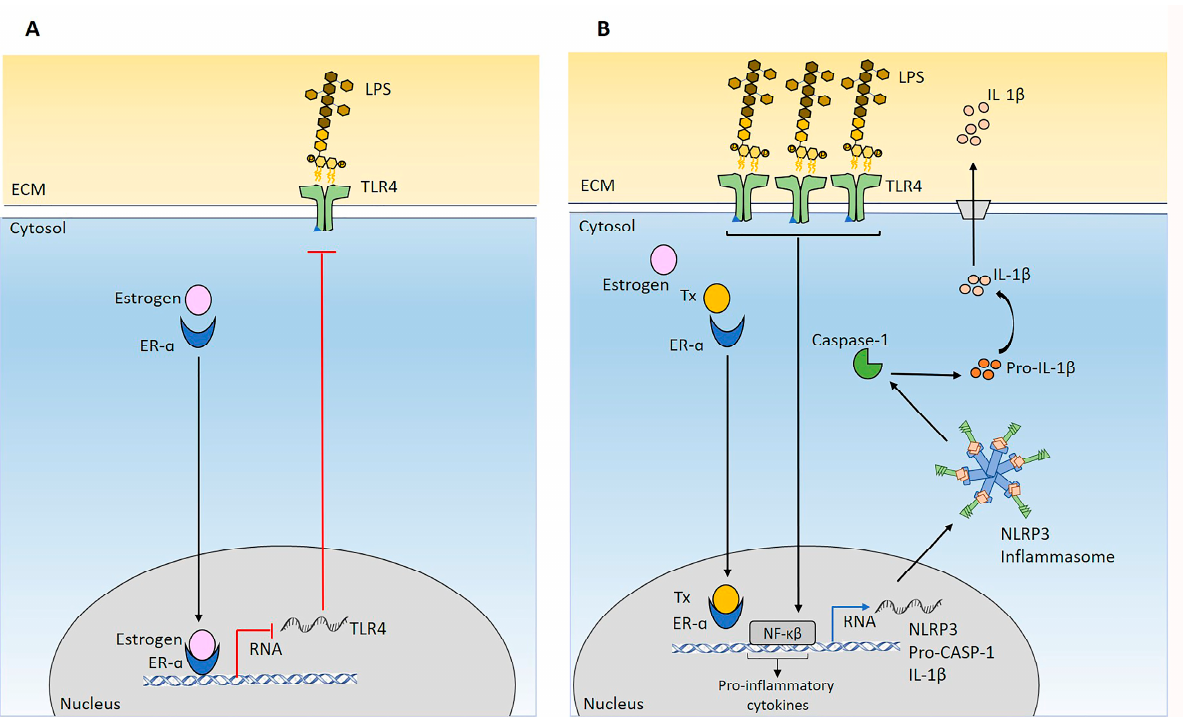
Figure 9. Schematic presentation of Tx mechanisms of NLRP3 activation in MCF7 cells. ( A ) Estrogen binds to the ER ‐α receptor, which blocks transcription of TLR4 receptor RNA. Blocking TLR4 tran ‐ scription could result in a reduction of TLR4 expression on the cell membrane. As a result, cells become less susceptible to LPS ‐ induced activation of the inflammasome. ( B ) Tx blocks ER ‐α . There ‐ fore, the expression of TLR4 becomes enhanced after exposure to LPS, a TLR4 ligand, and an NLRP3 priming signal. This will lead to increased transcription of NLRP3, pro ‐ caspase ‐ 1, and IL ‐ 1 β transcrip ‐ tion and protein synthesis. Activation signal (ATP) initiates inflammasome formation and proteo ‐ lytically cleaves pro ‐ caspase ‐ 1. Caspase ‐ 1 cleaves pro ‐ IL ‐ 1 β and creates the release of IL ‐ 1 β . The secretion of IL ‐ 1 β from primary BC tumors was shown to repress ER ‐ ɑ in adjacent tumor cells and confers an ER ‐ ɑ ‐ phenotype that causes an aggressive tumor type and Tx resistance [88]. The IL ‐ 1 β secretion of BC induces chemokine production that could facilitate their interaction with mesenchy ‐ mal stem cells, enhancing tumor growth or metastasis [89]. In line with this, IL ‐ 1 β was shown to promote matrix metalloproteinase ‐ 9 production and invasion in MCF7 cells [90]. Additionally, our previous study showed that NLRP3 ‐ induced IL ‐ 1 β secretion of MCF7 cells increases the capillary formation of human umbilical vein endothelial cells (HUVECs), which evidenced the angiogenesis and metastasis ‐ promoting effect of IL ‐ 1 β [9]. Supporting tumor ‐ promoting capacity was the demon ‐ stration of IL ‐ 1 β facilitating BC metastasis to the bone [91,92].